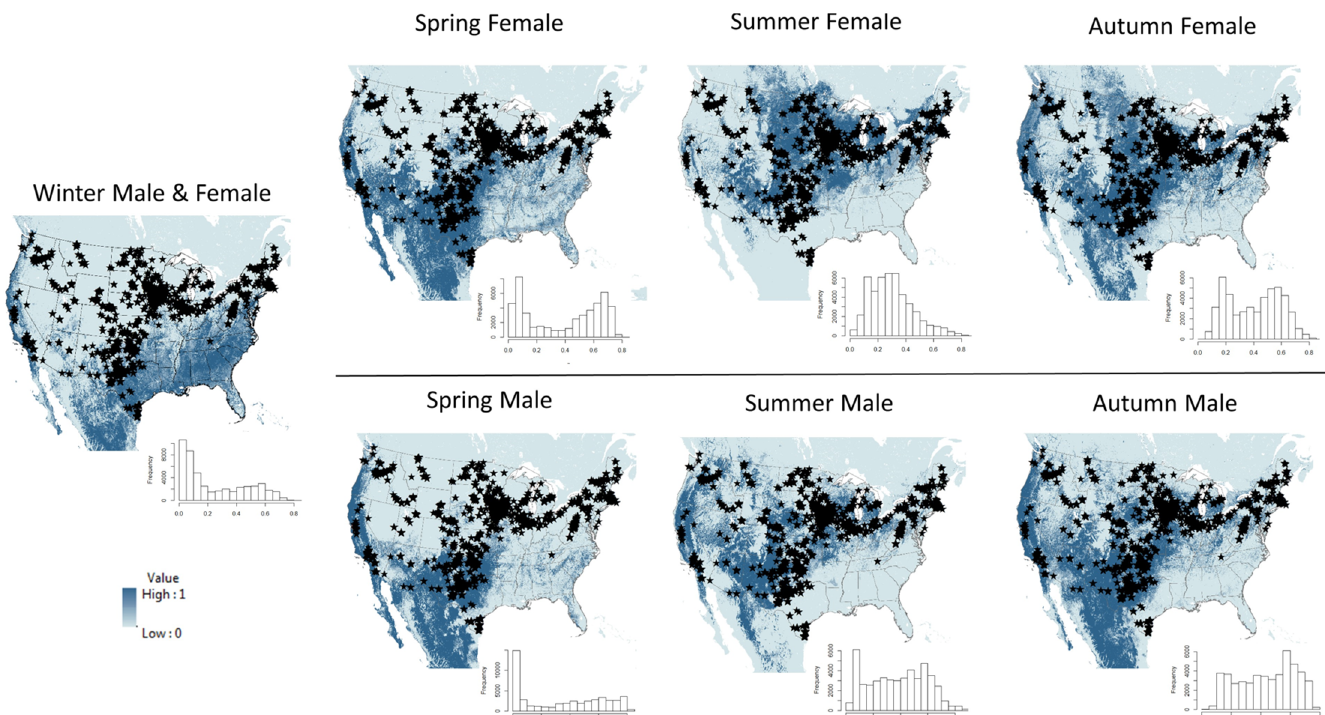
Fig 4. Ensemble maps for each season and sex for hoary bats ( Lasiurus cinereus ) in the United States using ensemble binary prediction from 5 species distribution model forms. Locations of > 47,000 industrial wind turbines in the contiguous United States are indicated by black stars. The color ramp indicates the proportion of the 5 SDM model runs for each season that are considered suitable habitat. Darkest blue indicates that all of the models predict the area to be suitable habitat, while lightest blue indicates that all of the models predict the area to be unsuitable habitat. The histogram associated with each map shows the empirical distribution for mean habitat suitability for all wind turbines in the United States, estimated using the 5 SDM approaches. Negative (left) skewness in the histograms, or higher frequencies of values toward the right side (= 1) of the horizontal axis, indicate overlap between modeled suitable habitat and turbine